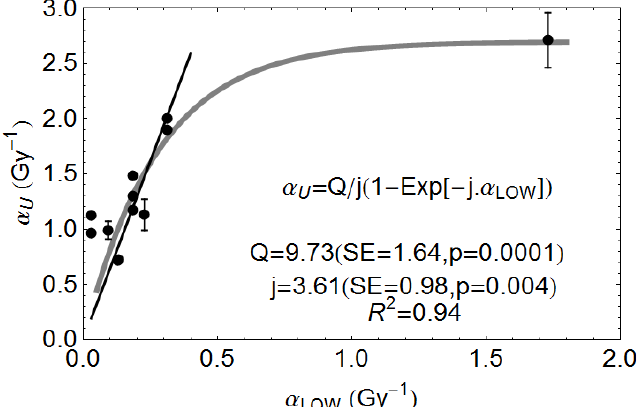
Figure 8. Plot the maximum α value at the LET-RBE turnover points and the control low Figure A1. Plot the maximum α value at the LET-RBE turnover points and the control low